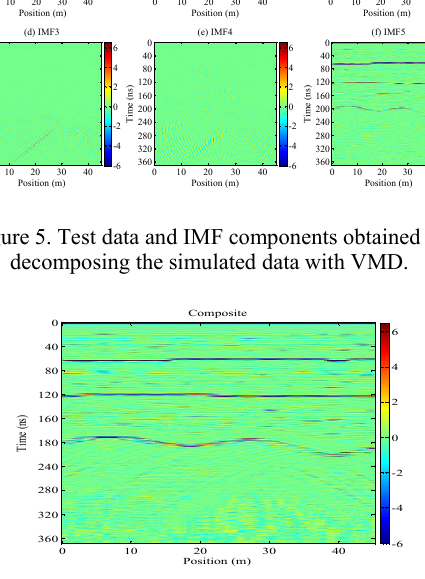
Figure 6. Combination of IMF2 and IMF5 of the simulated radar